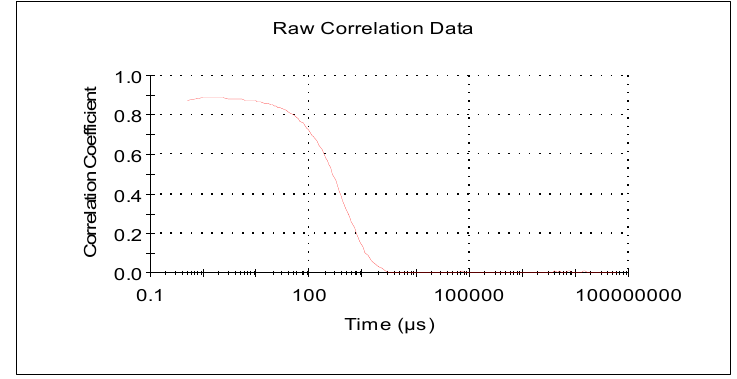
Figure 1. Correlation of the scattered light intensity in nanoliposome solution as a function of time.